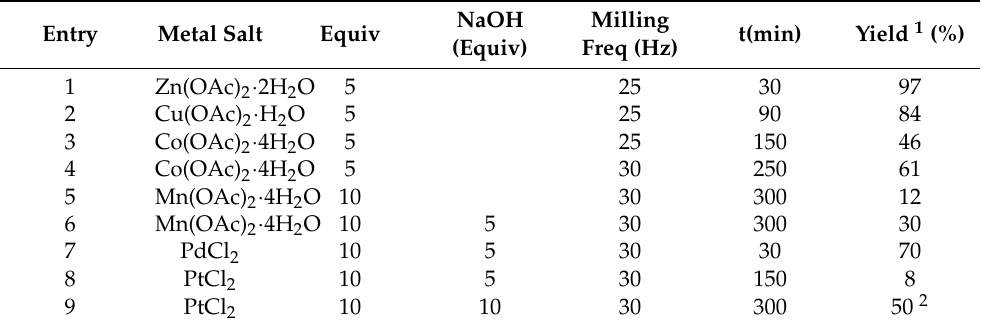
Table 1. Synthesis of metal complexes of 5,10,15,20- tetrakis -(3,4-methoxyphenyl)porphyrin, 3,4- OMeTPP, under mechanical